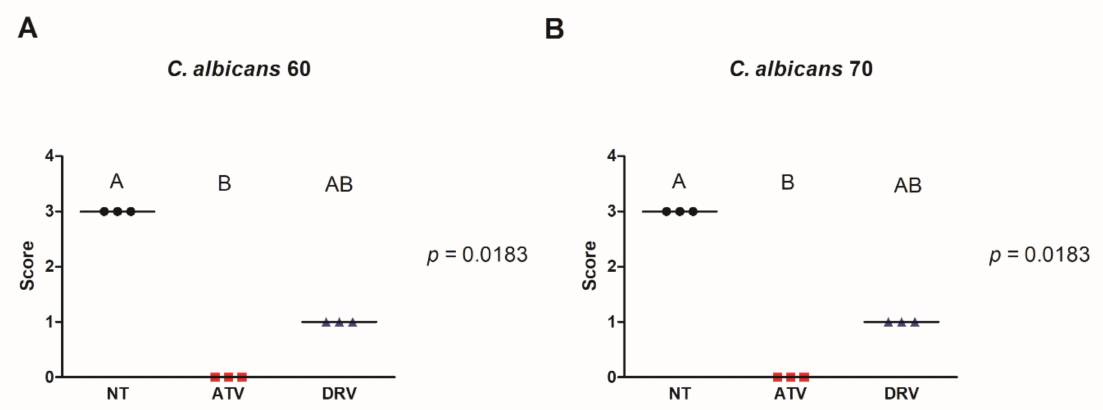
Figure 2. ATV and DRV decreased the number of C. albicans filaments. Scores attributed for hyphae formation of ( A ) C. albicans 60 (Ca60) and ( B ) C. albicans 70 (Ca70) not treated (NT) and treated with darunavir (DRV) and atazanavir (ATV). Results represent the mean of three replicates. DRV: darunavir; ATV: atazanavir; NT = not treated. Different letters (A, B) indicate significant differences ( p < 0.05).